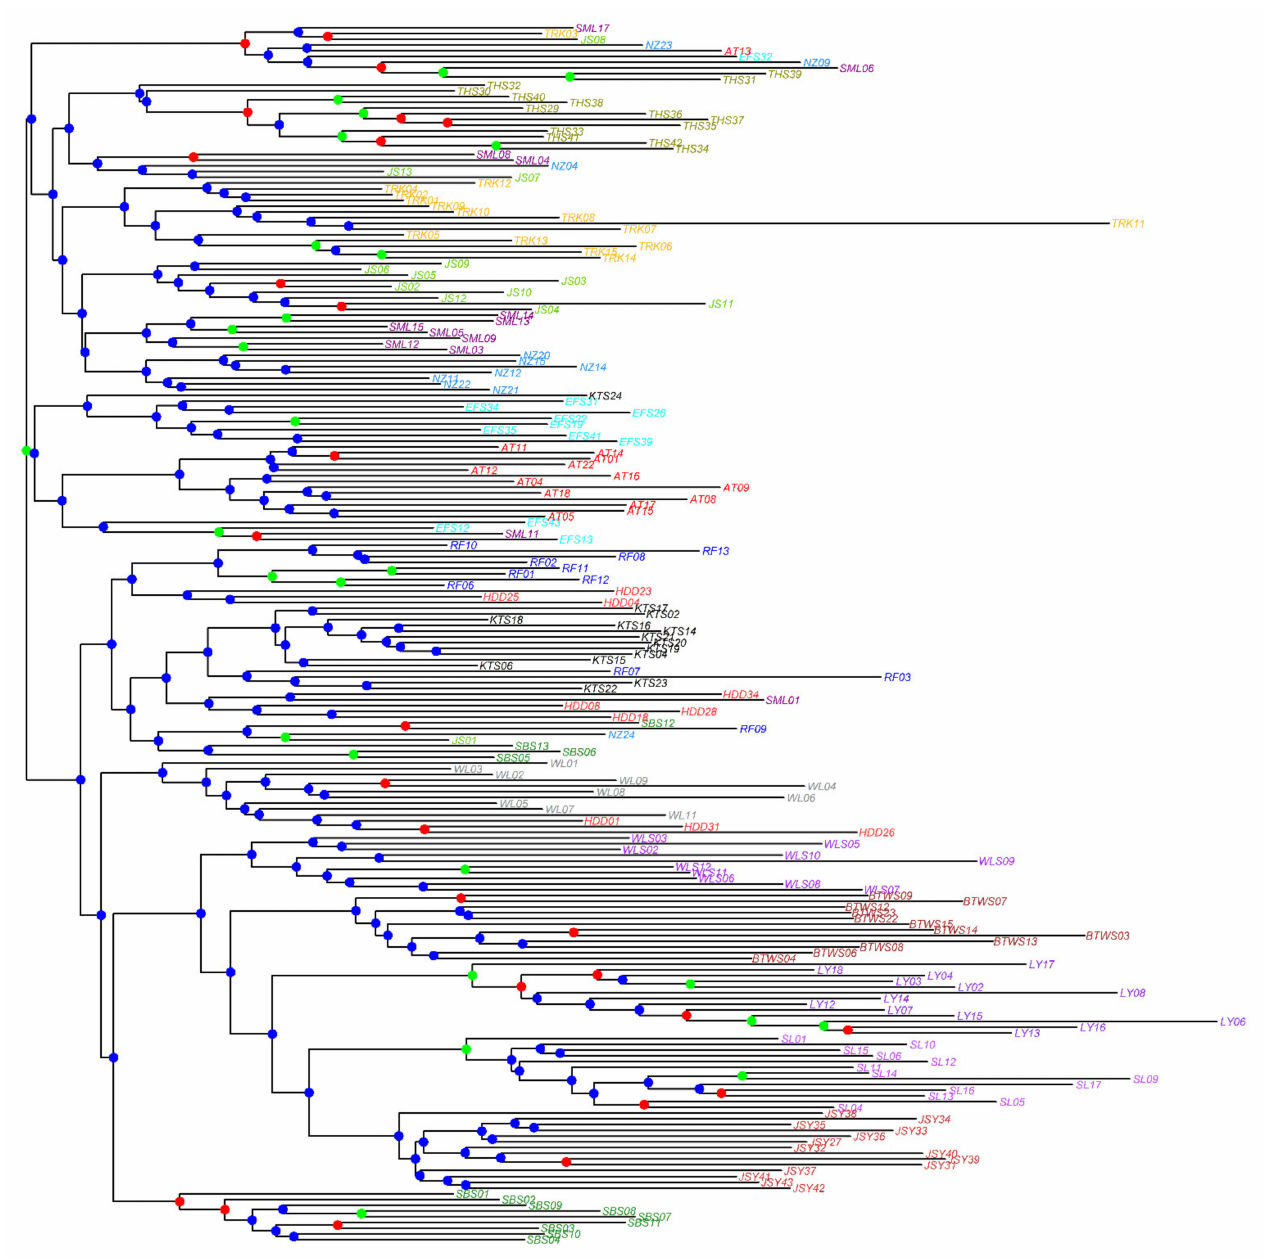
Figure 3. Neighbor-joining tree of 212 individuals of Zingiber kawagoii based on Nei’s genetic distances calculated using the total AFLP variation. Branch tip labels for individuals of different populations are colored differently. For each node, bootstrap support values greater than 70%, between 50% and 70%, and smaller than 50% are coded with green, red, and blue,